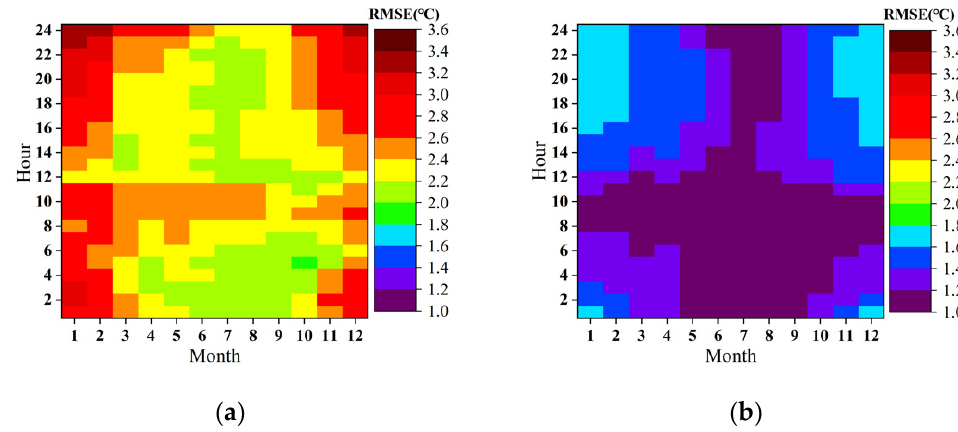
Figure 7. Monthly mean 24 h error variation: ( a ) RMSE for background; ( b ) RMSE for